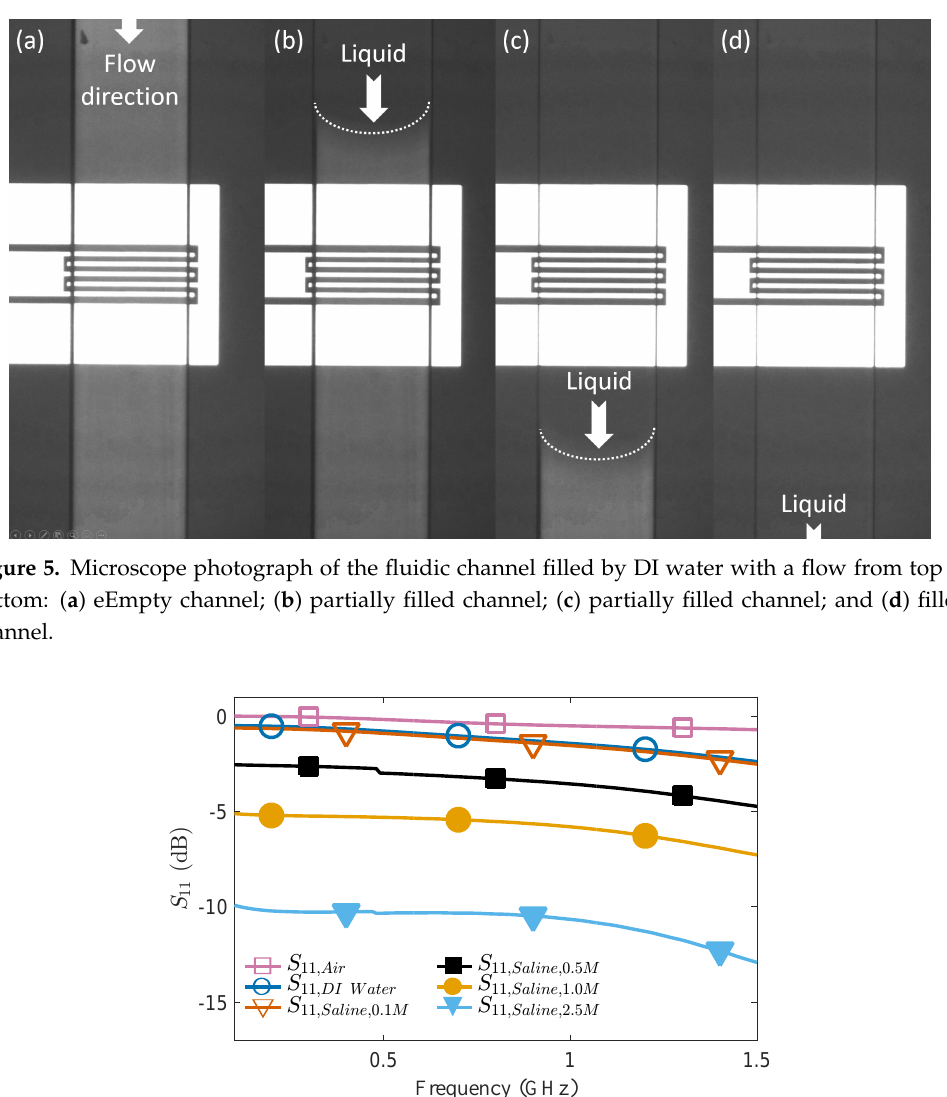
Figure 4. Magnets liquid interconnection between fluidic pump and microwave microfluidic chip.